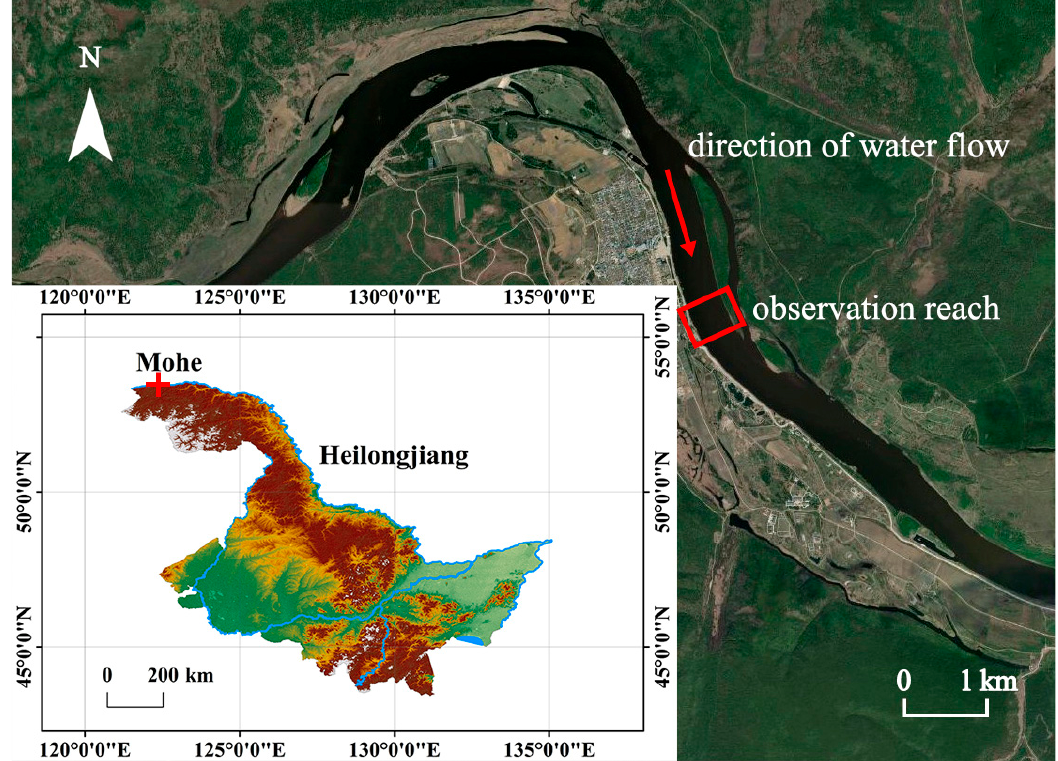
Figure 1. Schematic diagram of observation geographical